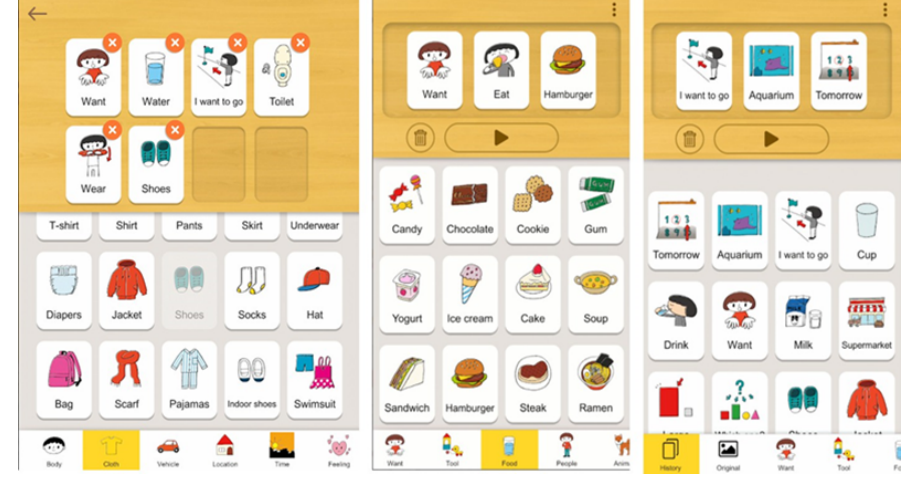
Figure 3. Card Talk App [39].